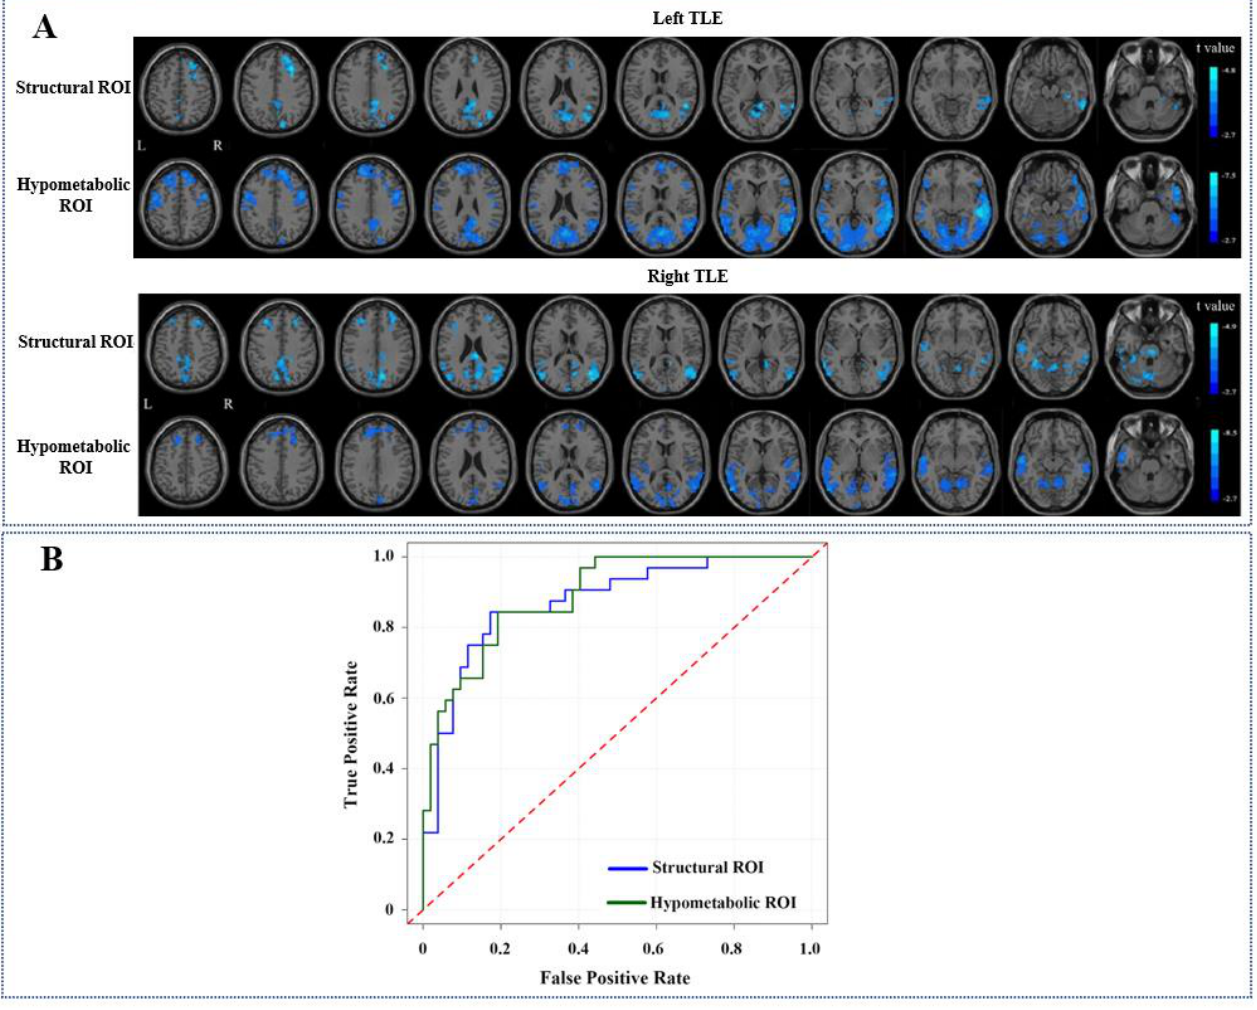
Figure 3. Whole-brain ROI-based FC alterations between TLE patients and controls. Brain areas with cold color indicate decreased FC with structural or hypometabolic ROI, respectively (( A ), GRF corrected, p < 0.01). ROC curves were constructed to assess the ability of FC values related to hypometabolic and structural ROI, respectively, in classifying TLE patients from controls ( B ). Table 3. Statistical maps and spatial coordinates (MNI space) of brain areas with functional altera- tions based on different ROIs in patients compared with controls.